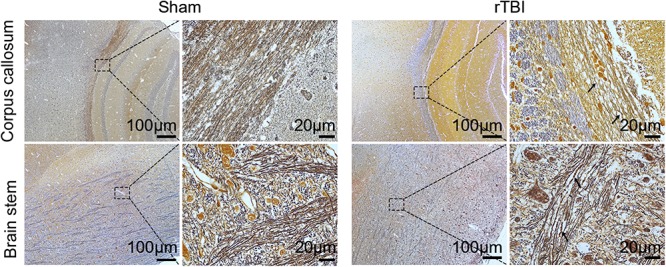
Post-repetitive traumatic brain injury (rTBI) axonal pathology was assessed by Bielschowsky silver staining. Representative immunohistochemical images showing the corpus callosum and brain stem at 24 h after last traumatic brain injury (TBI). The swelling, waving, and enlargement axons were observed (arrow indicated).